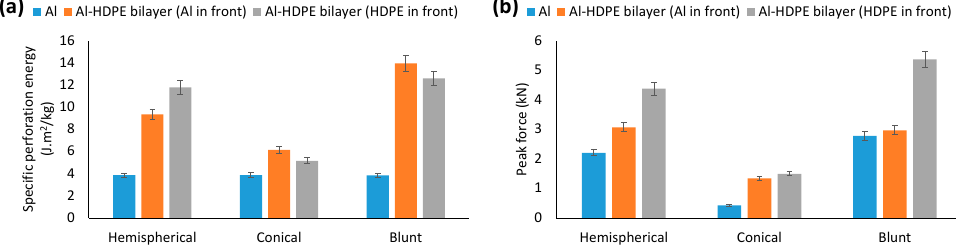
Figure 7. Comparison of ( a ) perforation energy and ( b ) peak force for Al–HDPE bilayers under hemispherical, conical and blunt indenters.